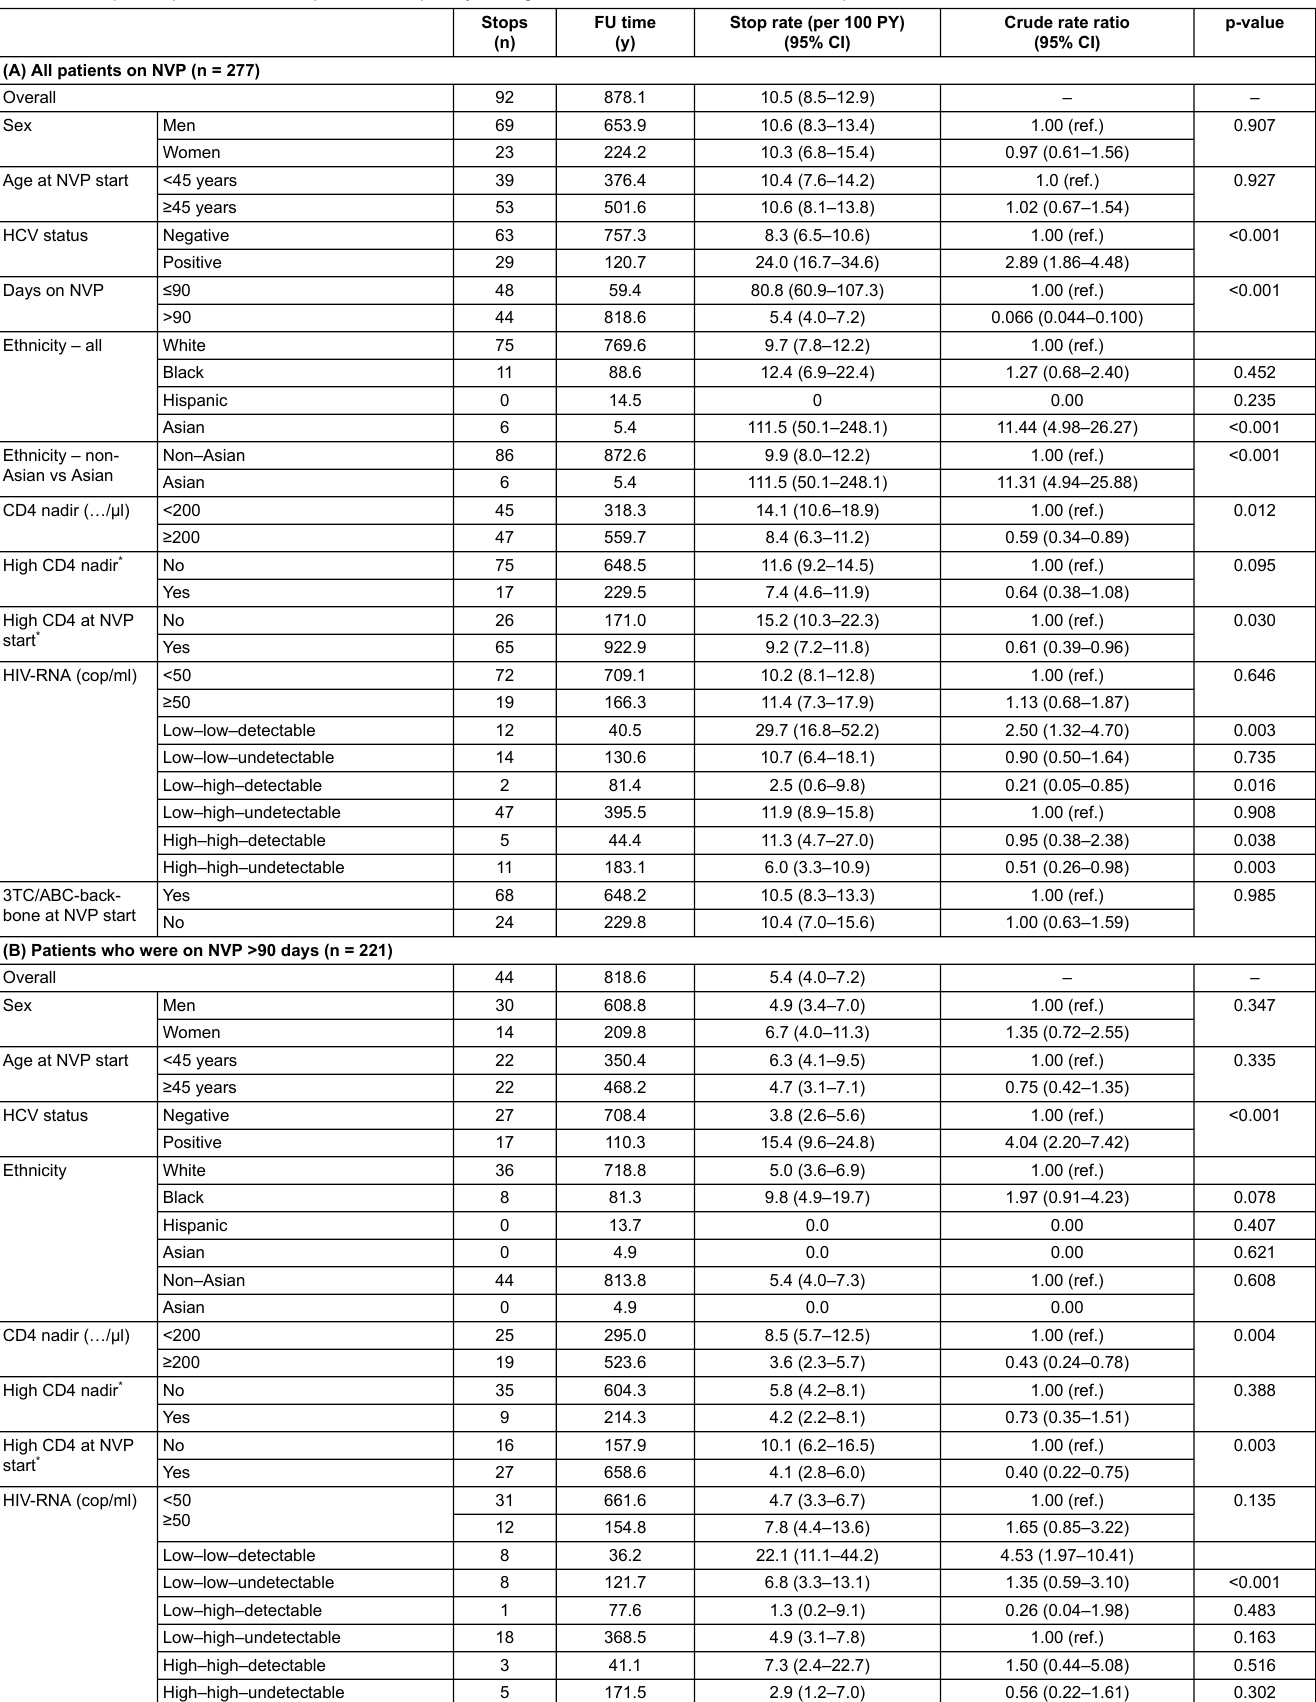
Table 2: Nevirapine stop rates in all nevirapine first therapies by sex, age, HCV-serostatus and duration on nevirapine.